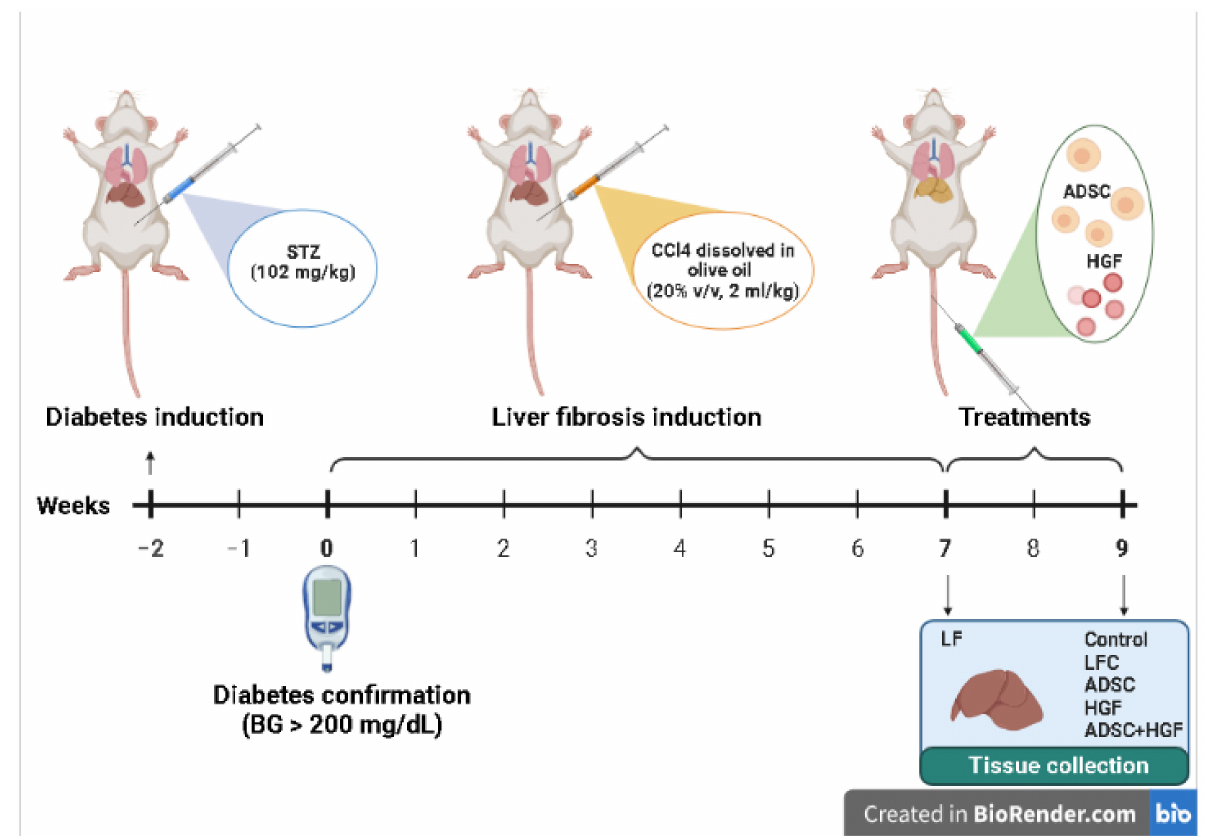
Figure 1. The experimental design of the in vivo